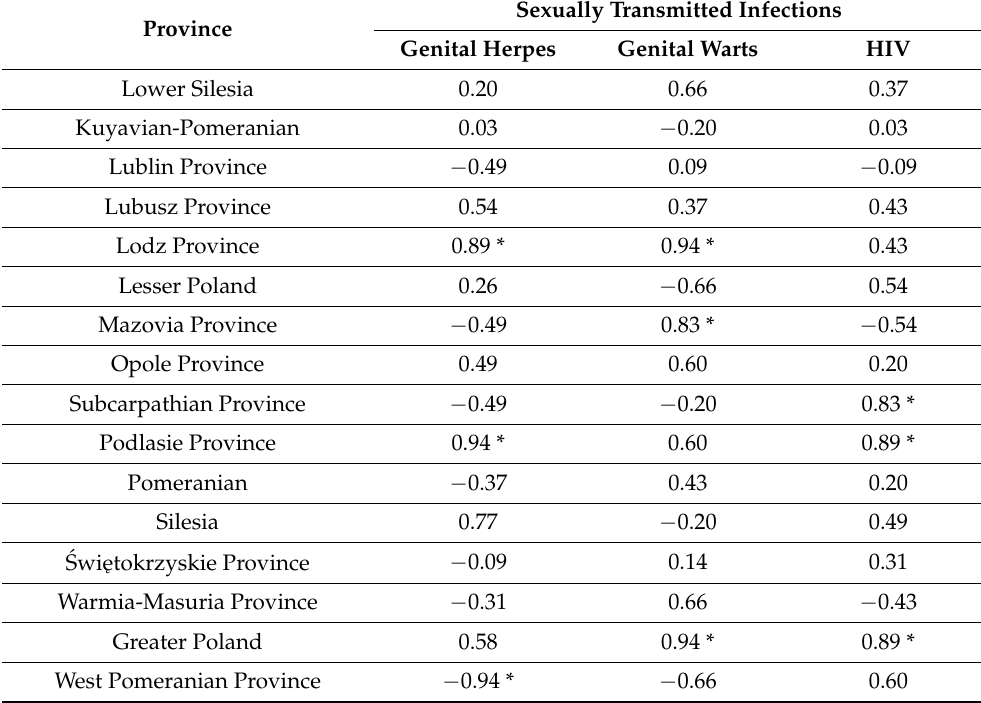
Table 2. Spearman rank correlation coefficients of STI for